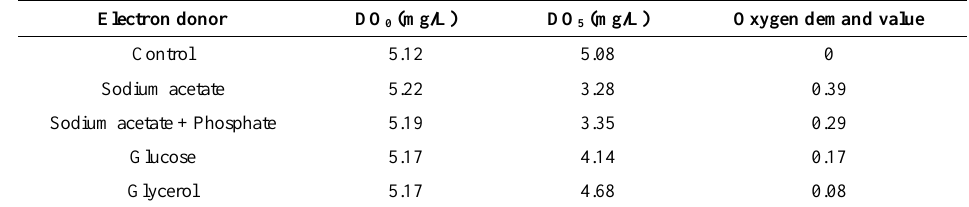
Table 6. Microcosm study results of site B's indigenous bacteria oxygen demand from different electron